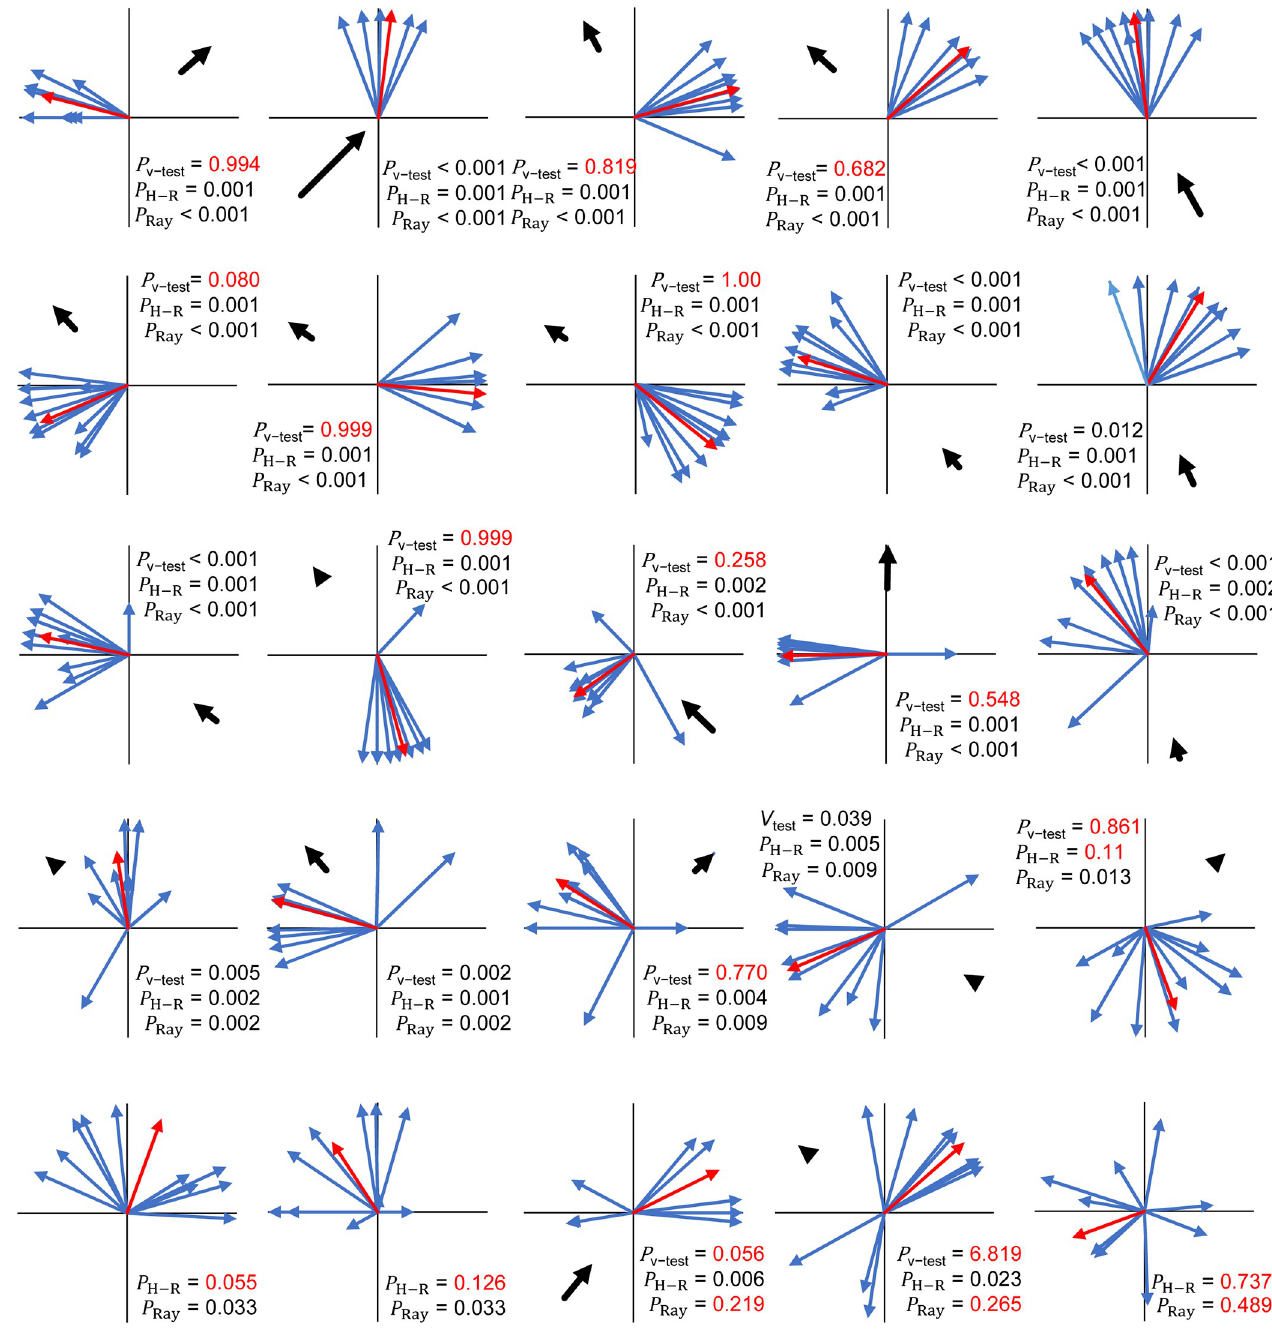
Fig 5. Flight directions and lengths of HR tagged Zeugodacus cucurbitae for experiment 3 (field cage). Each replicate consisted of a series of 10 flights with a single tagged fly. Blue arrows represent individual flights, while red arrows show the mean flight direction and length.